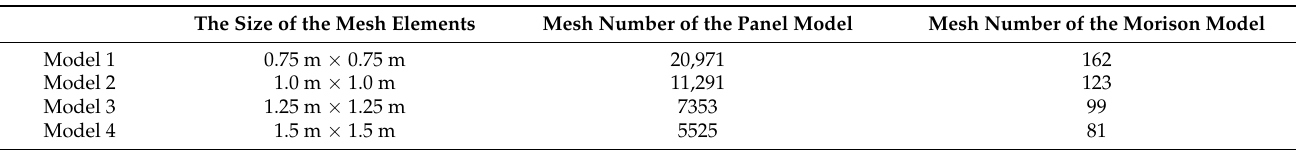
Table 4. The different mesh models of the floating